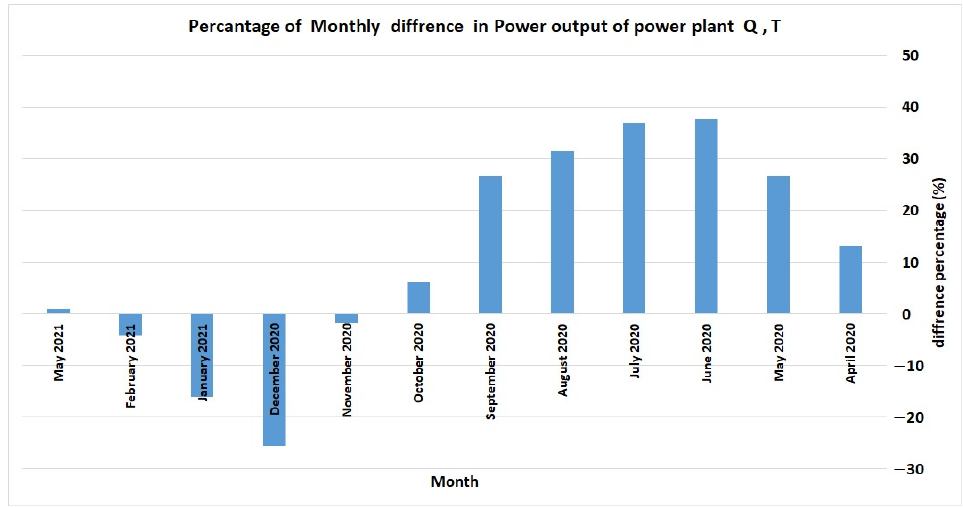
Figure 7. Comparison of percentage changes in monthly energy production of Q and T power